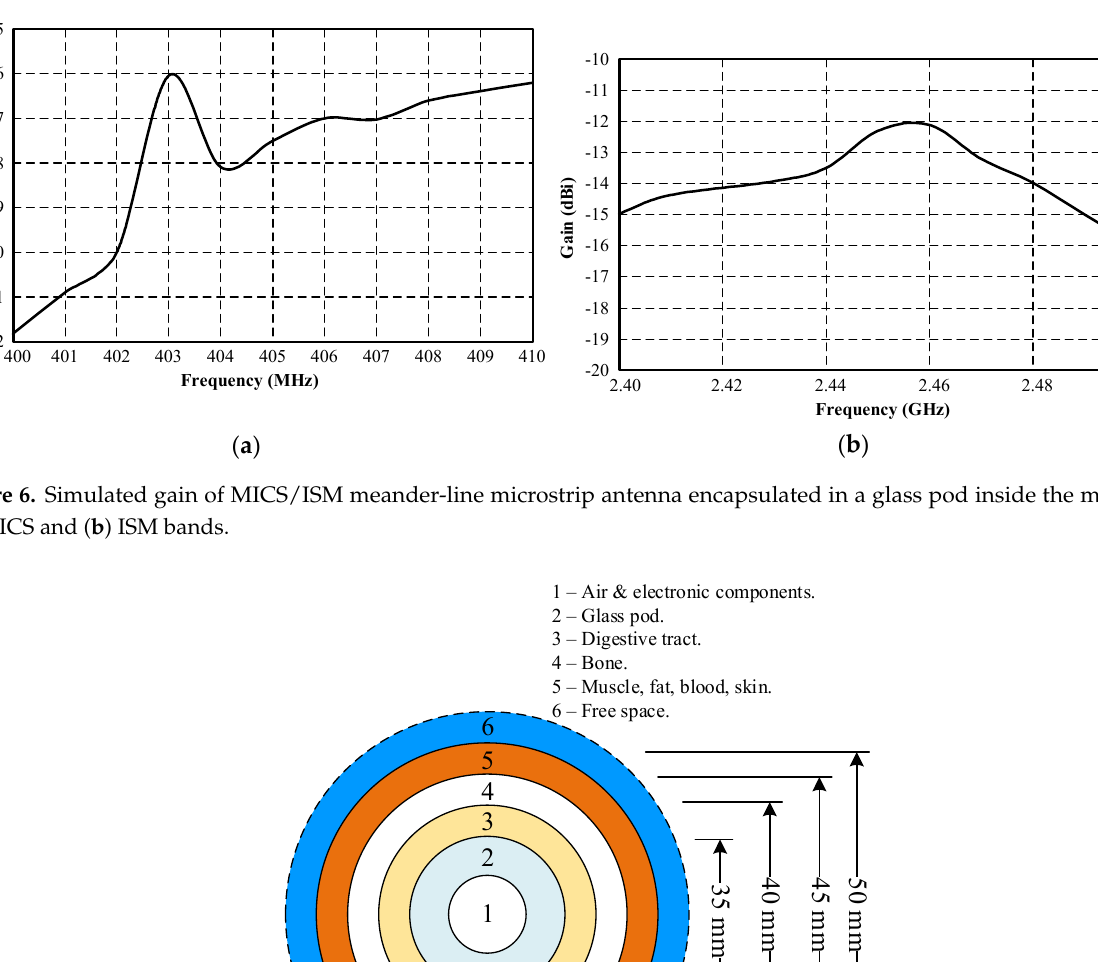
Figure 5. Simulated radiation pattern of MICS/ISM meander-line microstrip antenna encapsulated in a glass pod inside the muscular cubicle: ( a ) xy and ( b ) yz planes.